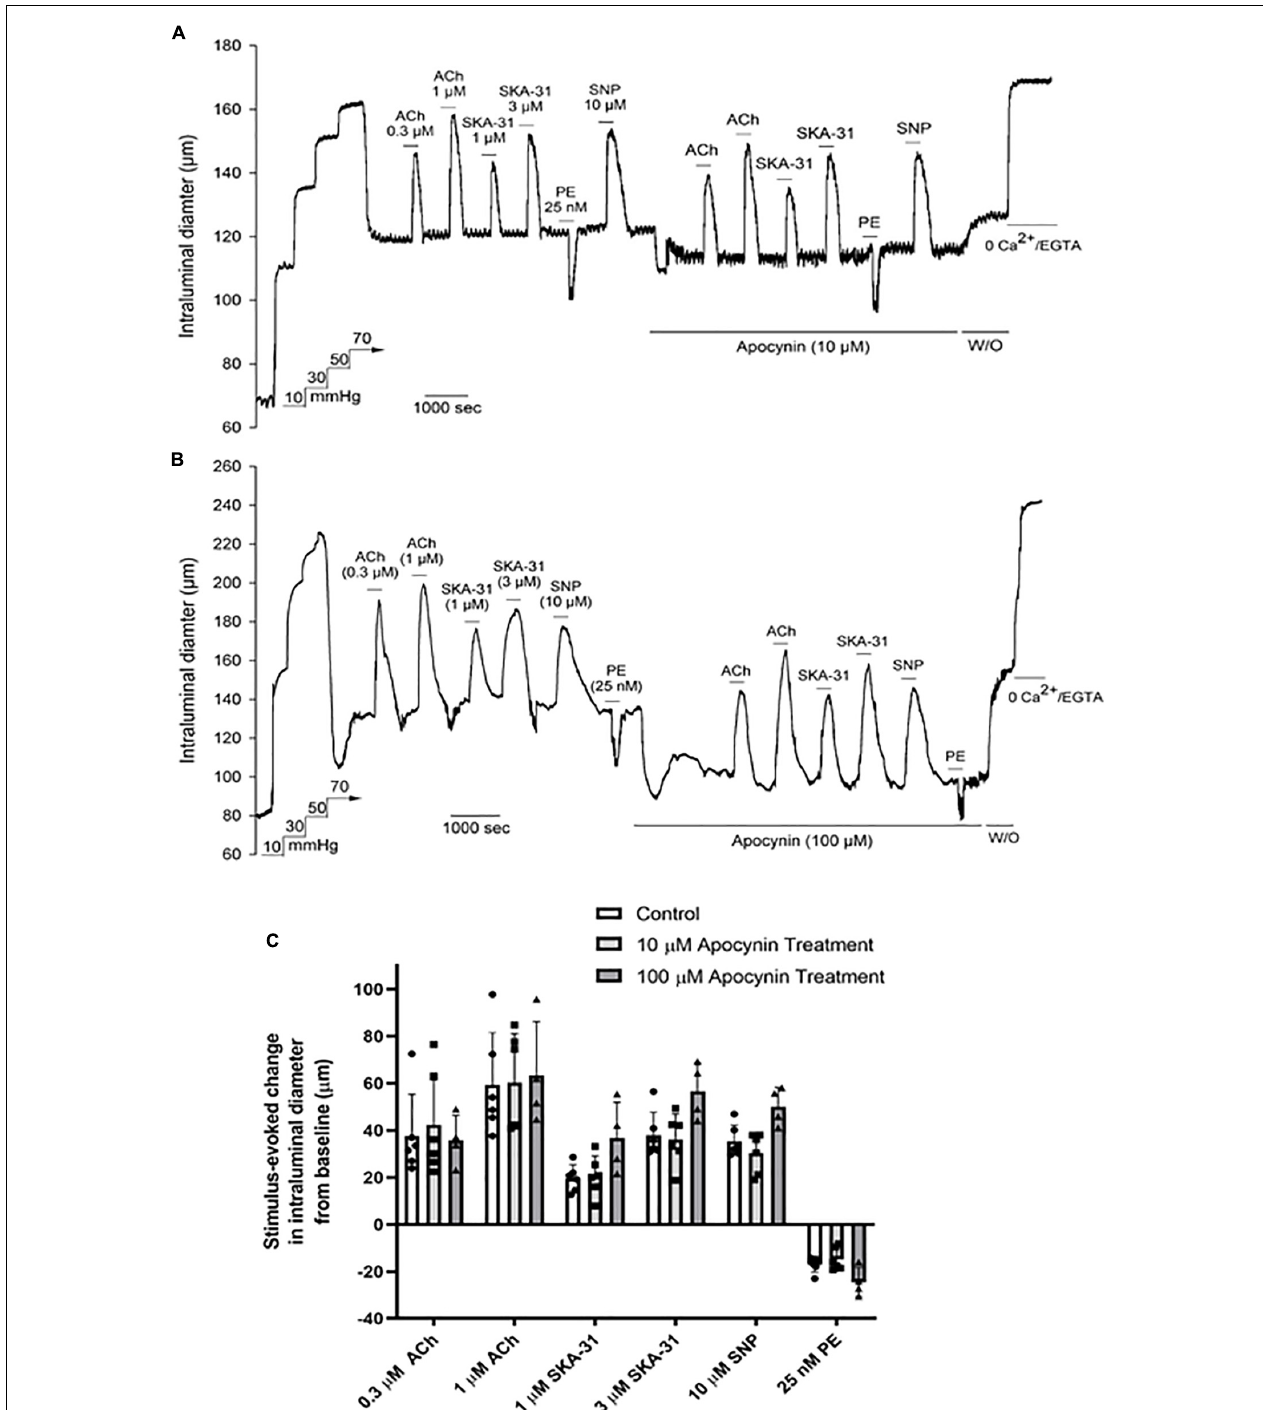
FIGURE 5 | The non-selective NOX inhibitor apocynin has minimal effects on vasoactive responses in Sprague–Dawley rat cremaster arteries. The representative tracings in panels (A,B) show the effects of endothelium-dependent and -independent vasoactive agents in the absence and presence of 10 µ M and 100 µ M apocynin treatment, respectively. Agents were present in the bath solution as indicated by the horizontal bars above and below the tracings. Maximal arterial diameter was determined at the end of the protocol by addition of nominally Ca 2 + free physiological saline solution (i.e., 0 added CaCl 2 + 2 mM EGTA). The histogram in panel (C) quantifies the absolute changes in intraluminal diameter evoked by each vasoactive agent in the absence and presence of 10 µ M and 100 µ M apocynin treatment ( n = 8 arteries and 4 arteries, respectively). Data are presented as means ± S.D. No statistically significant differences from control responses were noted, as determined by a one-way ANOVA and a Newman–Keuls post hoc test.